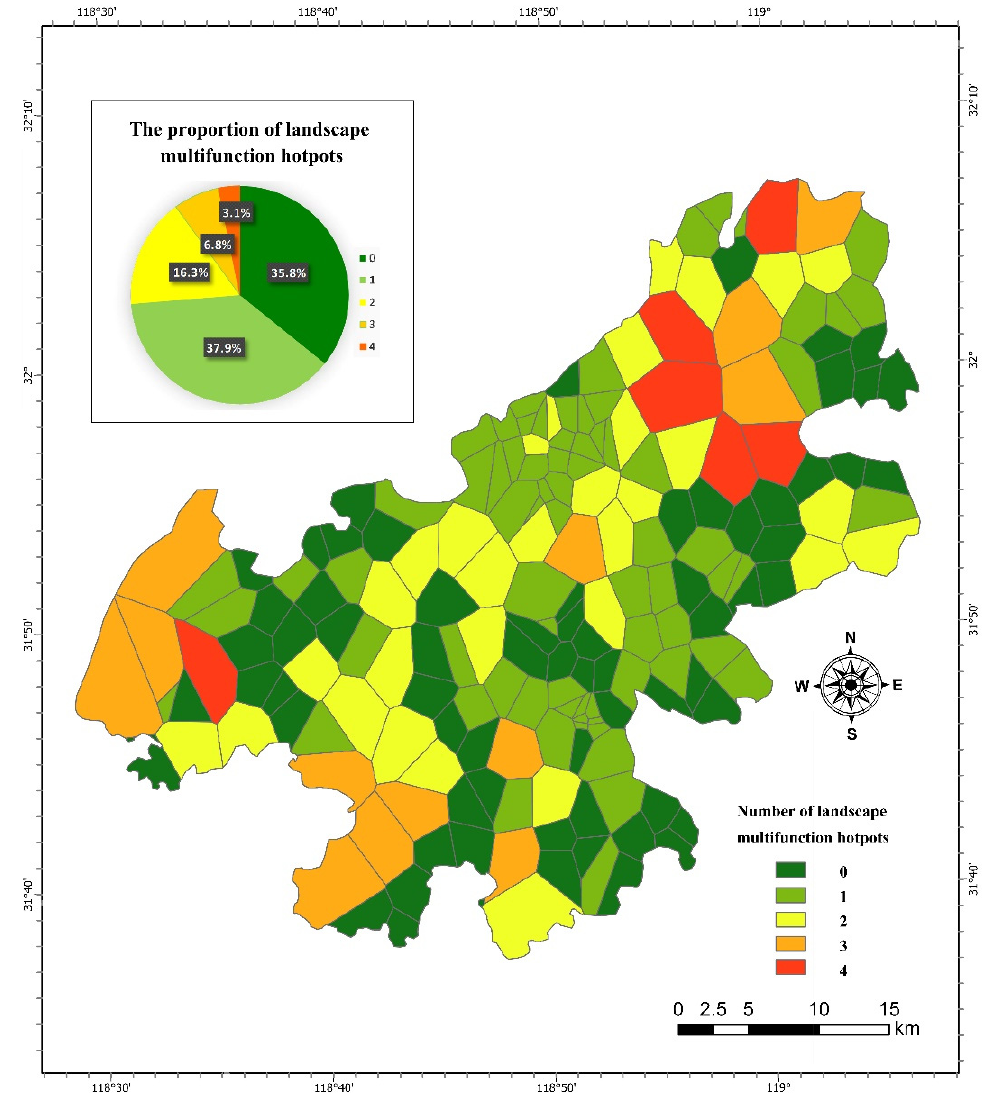
Figure 5. Spatial distribution of landscape multifunction hotspots in Jiangning District, Nanjing.